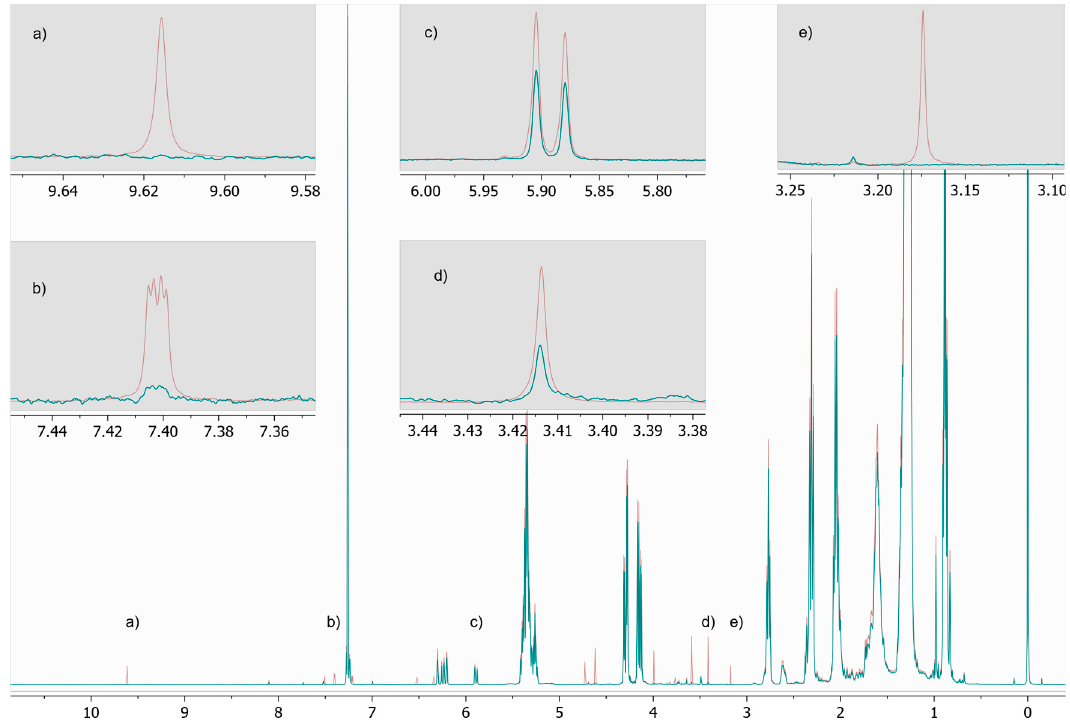
Figure 1. Representative 1H NMR spectrum of an authentic coffee sample showing target resonances in magnification (HMF ( a ), furfuryl alcohol ( b ), kahweol ( c ), caffeine ( d ), OMC ( e )). Foods 2020 , 9 , x FOR PEER REVIEW